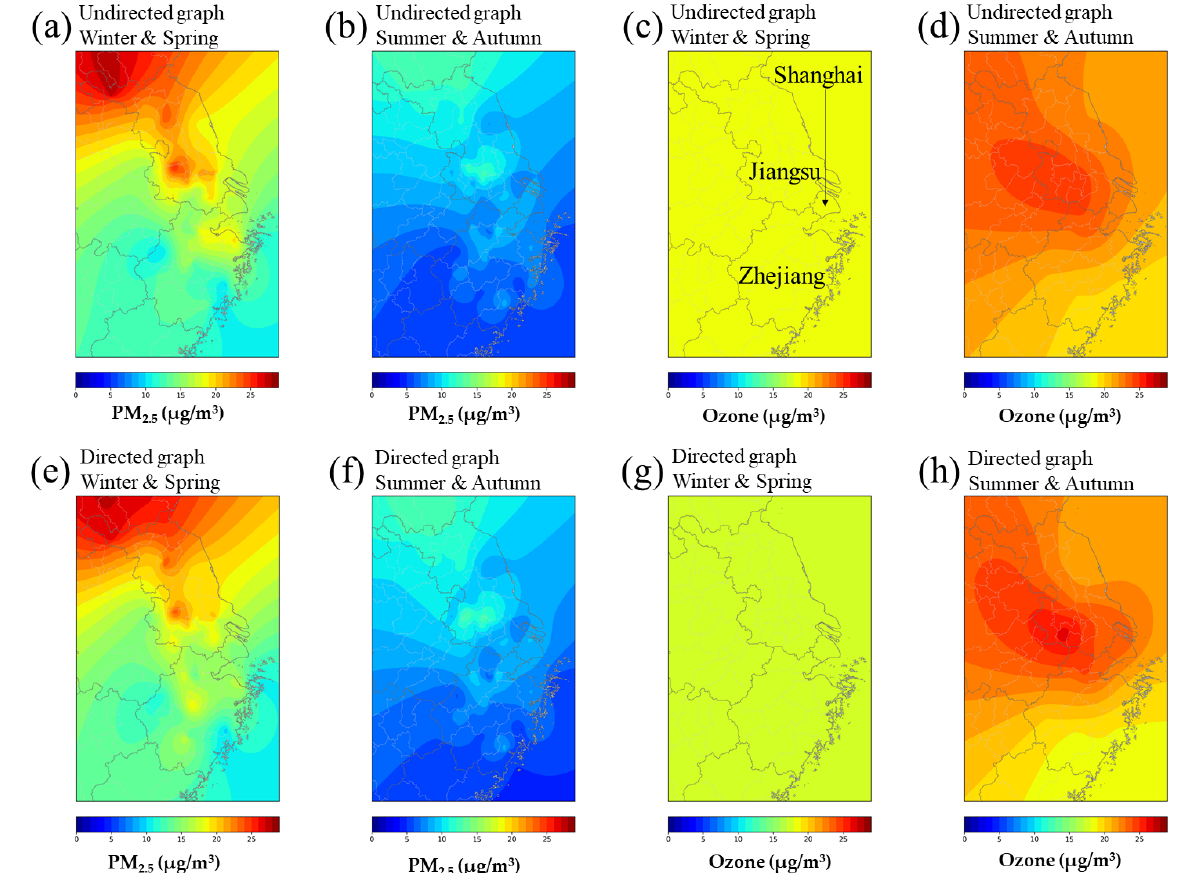
Figure 7. Spatial distributions of the mean MAE of 24 h air quality predictions based on the DCRNN model in the Yangtze River Delta region: ( a ) undirected graph, PM 2.5 in winter and spring; ( b ) undirected graph, PM 2.5 in summer and autumn; ( c ) undirected graph, ozone in winter and spring; ( d ) undirected graph, ozone in summer and autumn; ( e ) directed graph, PM 2.5 in winter and spring; ( f ) directed graph, PM 2.5 in summer and autumn; ( g ) directed graph, ozone in winter and spring; ( h ) directed graph, ozone in summer and